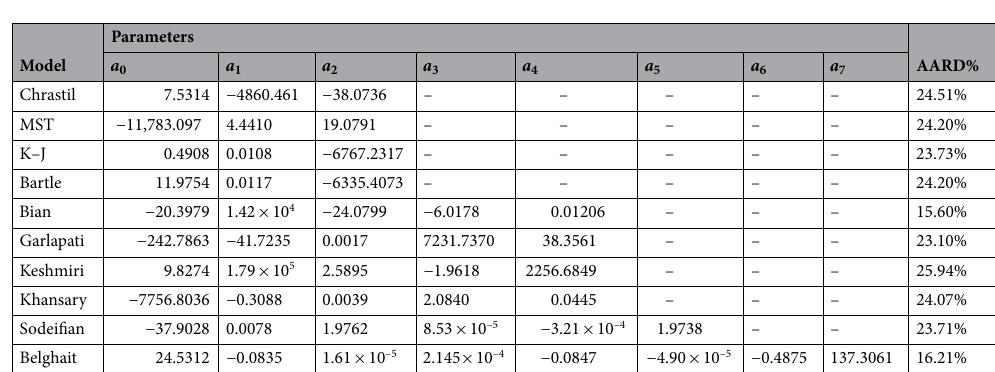
Table 4. Parameter values in semi-empirical